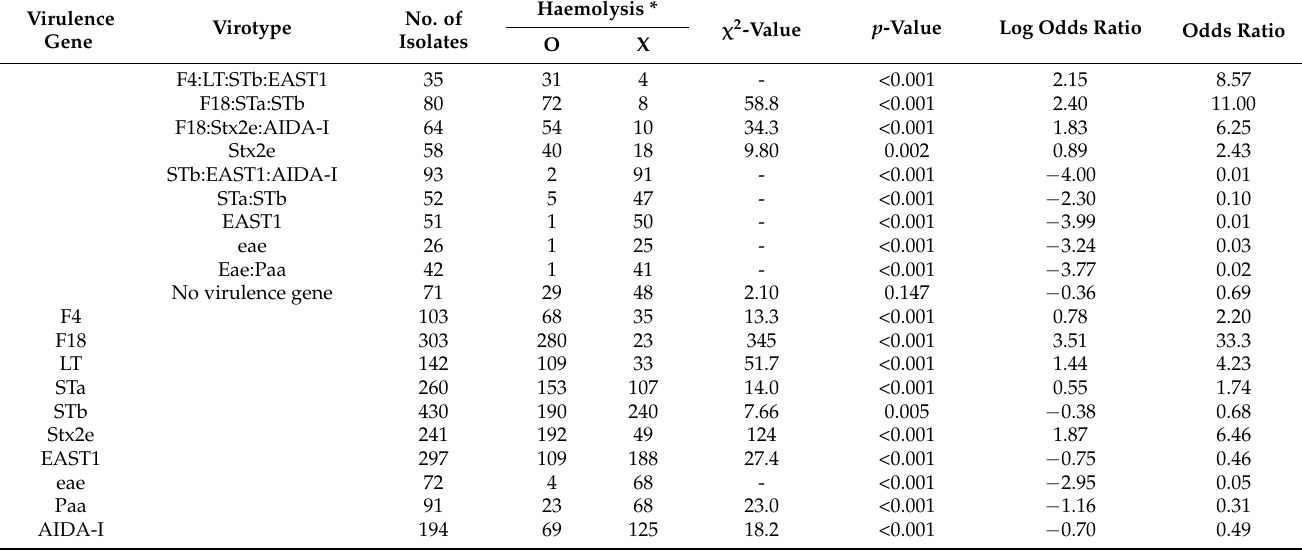
Table 2. Association between virotype and haemolysis of E. coli detected in post-weaning piglets. Virulence